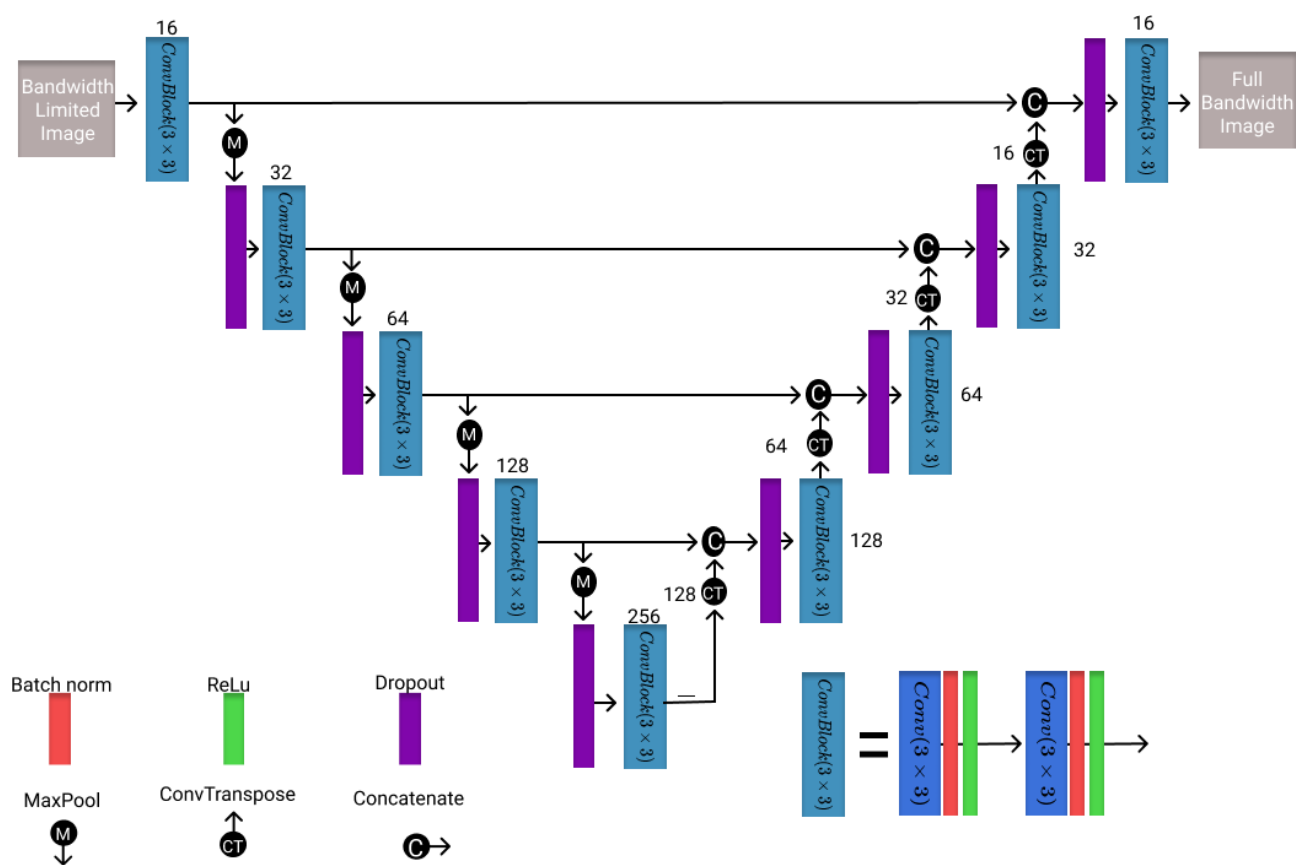
Figure 2. Visualization of the U-Net architecture utilized in this study with different blocks and the number of filters present in each layer.